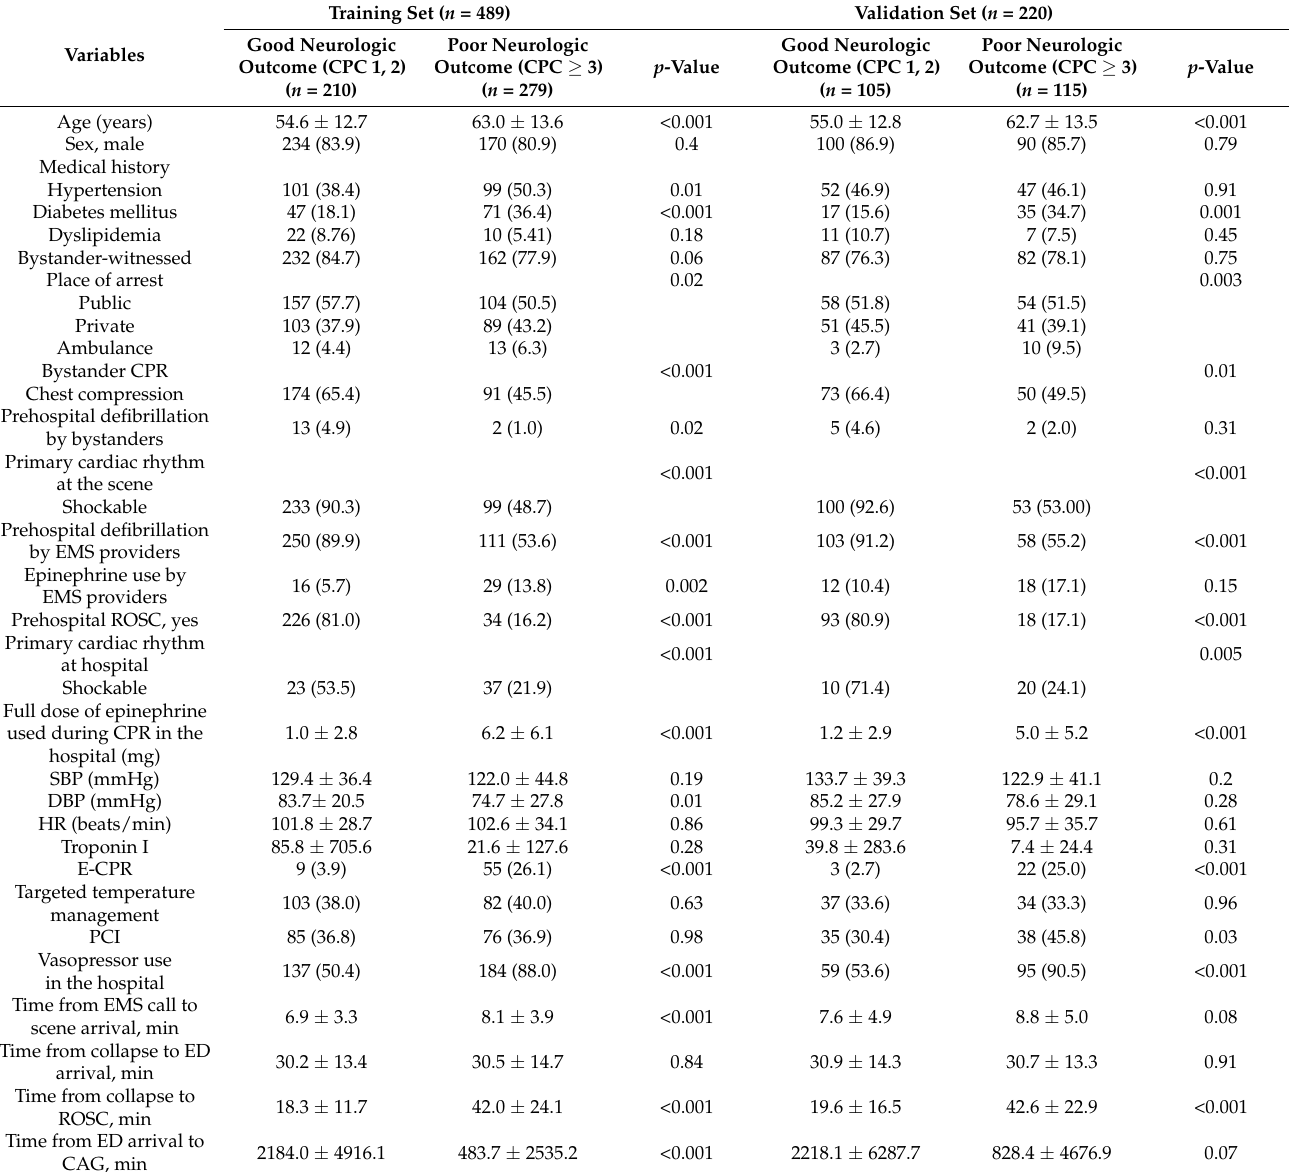
Table 3. Patient demographics and clinical characteristics according to neurologic outcomes at